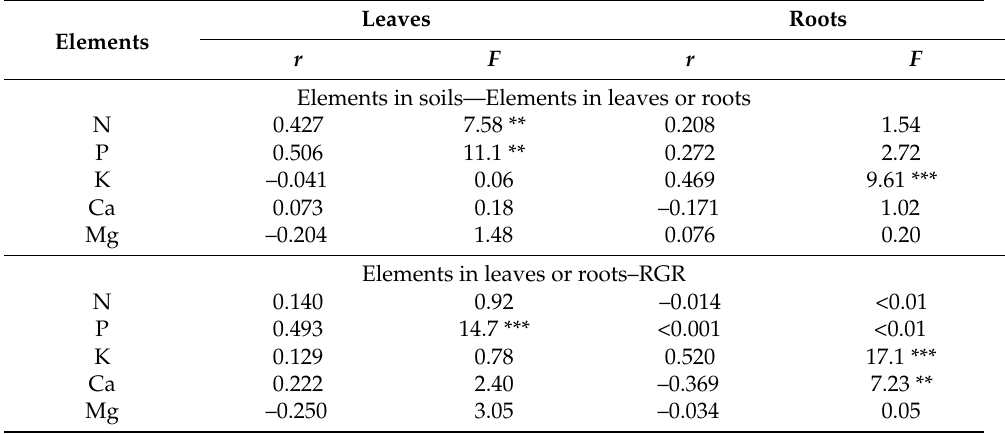
Table 6. Regression coefficients of relationships between concentrations of elements in the leaves or roots of teak seedlings (dependent variable) and concentrations of elements in the soils (independent variable, Nov. 2015, n = 36), and the RGR (dependent variable) and concentrations of elements in the leaves or roots (independent variable) of teak seedlings ( n = 48). ** p < 0.01 and *** p < 0.001. Leaves Roots Elements r F r F Elements in soils—Elements in leaves or roots N